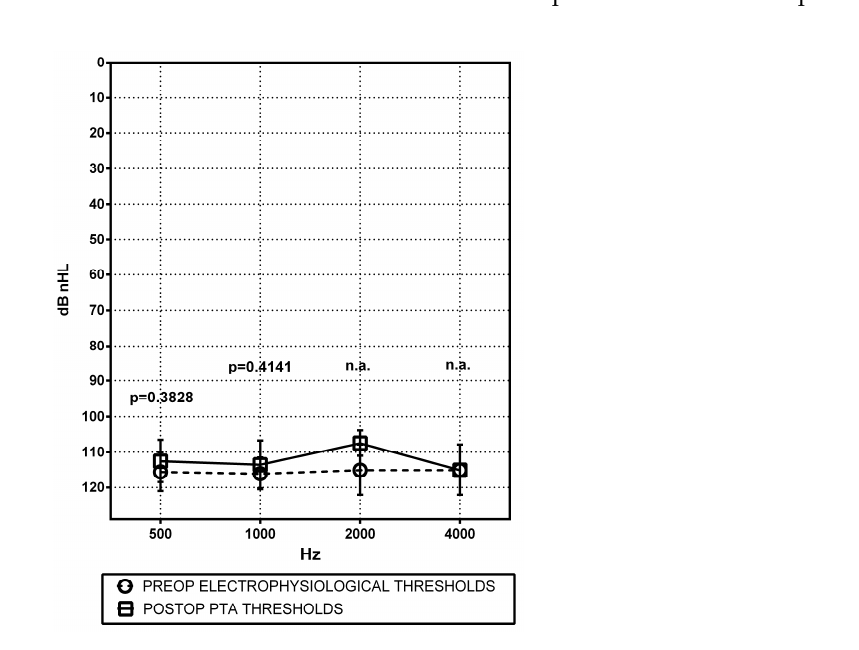
Figure 4. Electrophysiological auditory measurements (before 6 months of age; RW-ECoG tone burst at 500 and 1000 Hz, better thresholds between tone burst at 1000, 2000 Hz and click) vs. PTA outcomes (later than 5 years after surgery) in the 10 children with residual hearing.